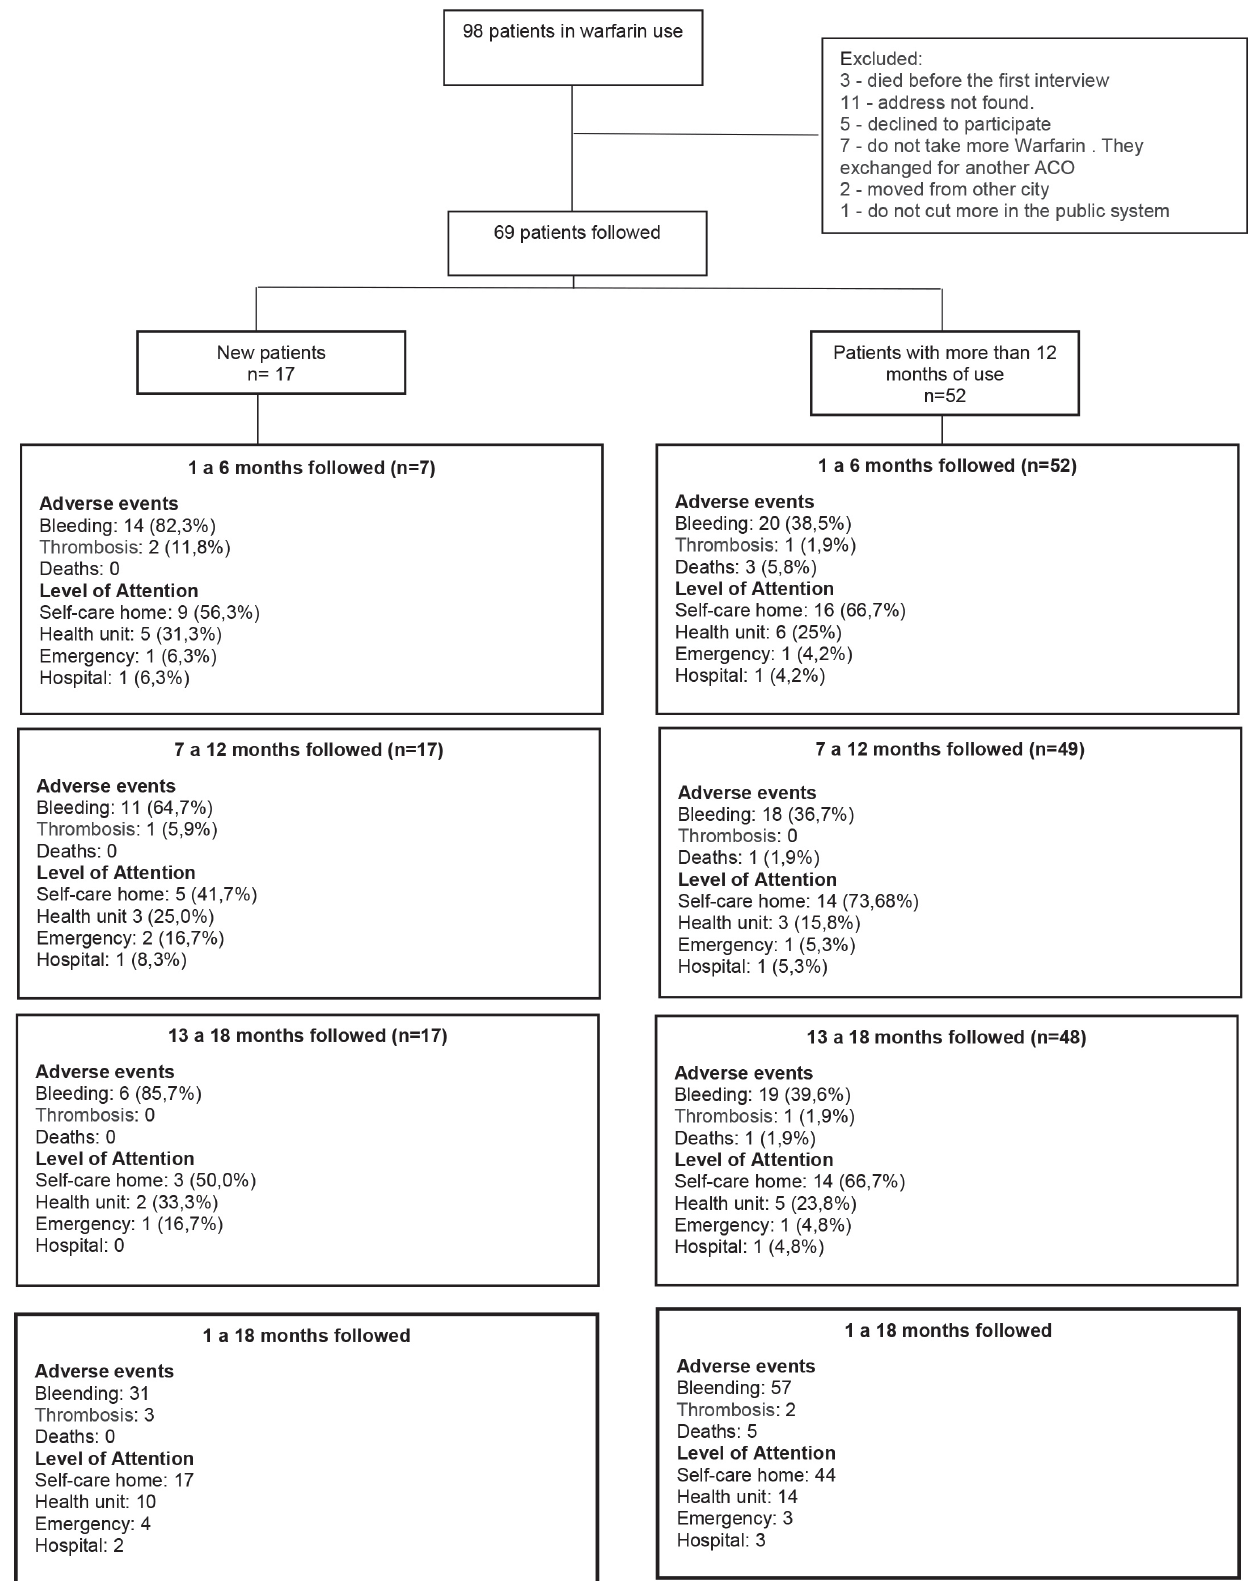
FIGURE 1 - Itinerary of patients for the resolution of adverse events, according to the warfarin use of time and level of attention to every six months in cohort monitoring in the city of Ijuí/RS. n =